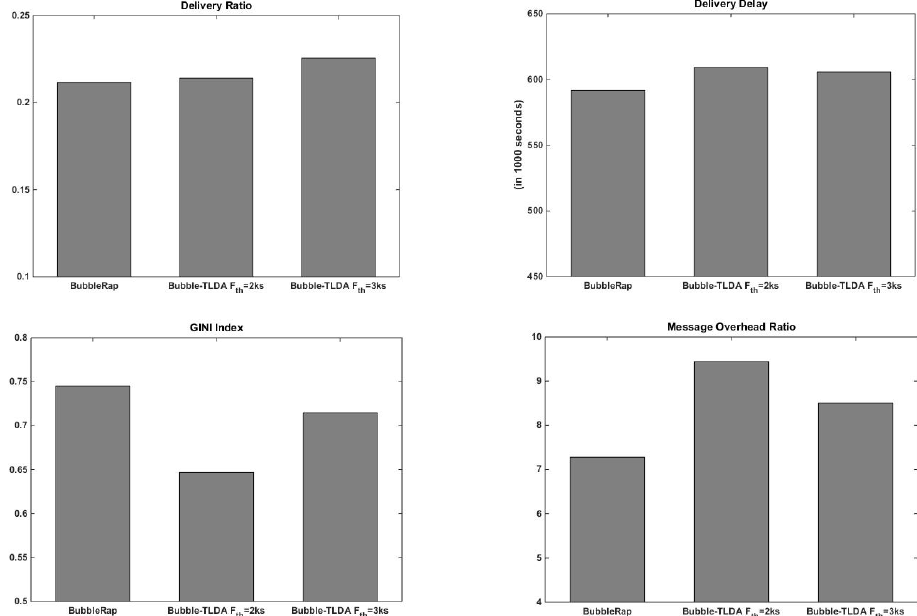
Figure 9. Performance evaluation of BubbleRap and Bubble-TLDA ( ξ = 0.8) for the Sassy mobility scenario. In this case, Bubble-TLDA slightly improves the traffic distribution (indicated by a reduced GINI index), while keeping other delivery performances as high as those of